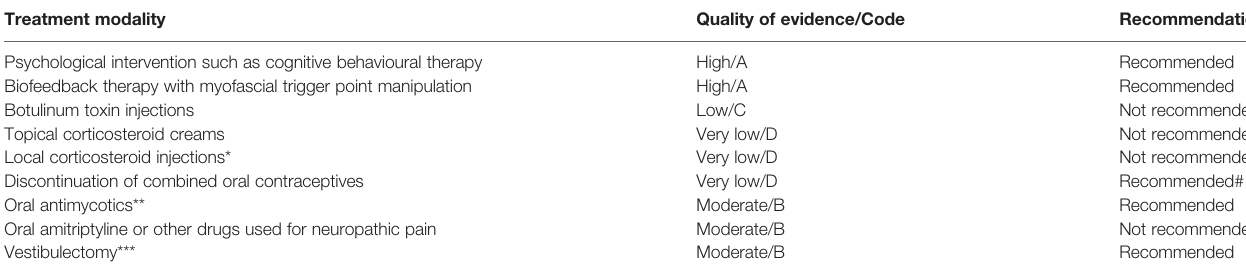
TABLE 1 | Selected treatment modalities for localised provoked vulvodynia (LPV) by quality of evidence. Treatment modality Quality of evidence/Code